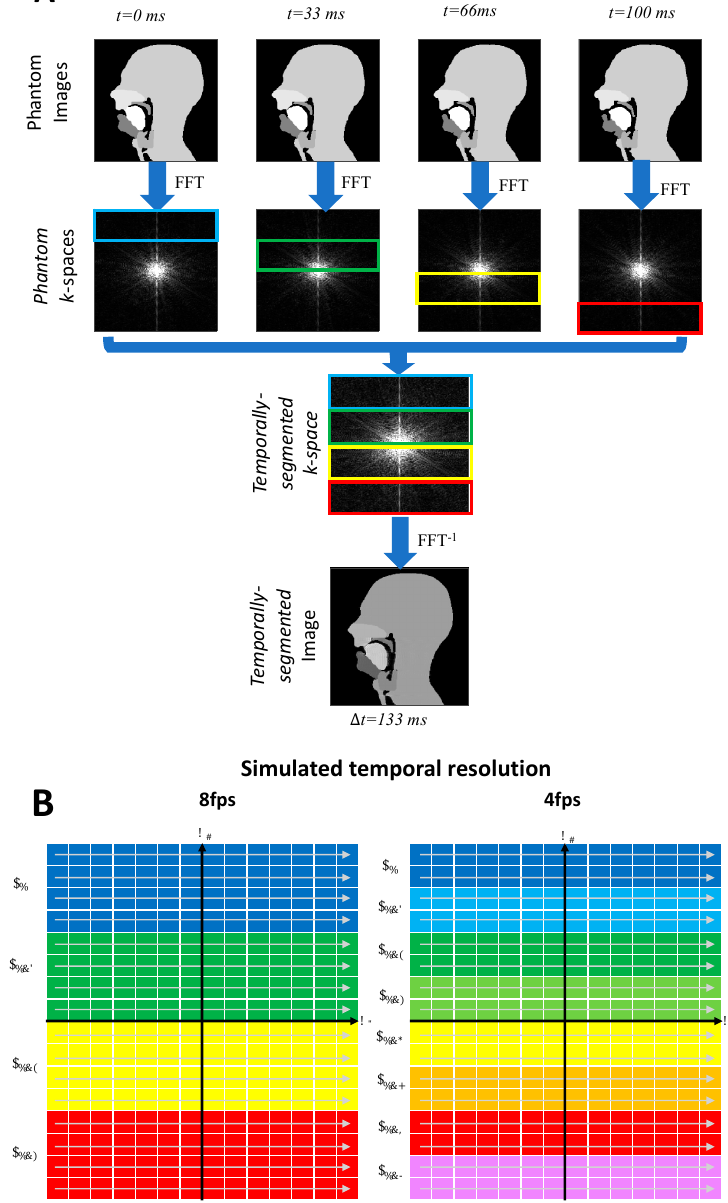
Figure 4. Segmented k-space Cartesian acquisitions can be simulated from the original 30 frames per second (fps) phantom. For example, a frame rate of 8 fps is obtained by assembling segments from 4 consecutive images from the original phantom ( A ). Likewise, a 4 fps will be created by assembling segments from 8 consecutive images from the fully sample numerical simulation ( B ). Segments are selected in k-space in a reverse linear fashion.